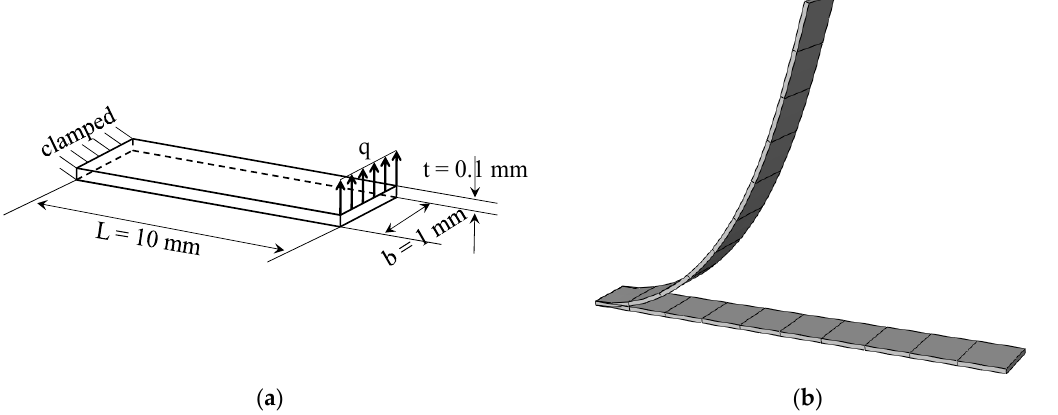
Figure 5. Cantilever beam: ( a ) geometry and ( b ) undeformed and deformed configurations. Materials 2018, 11, x FOR PEER REVIEW